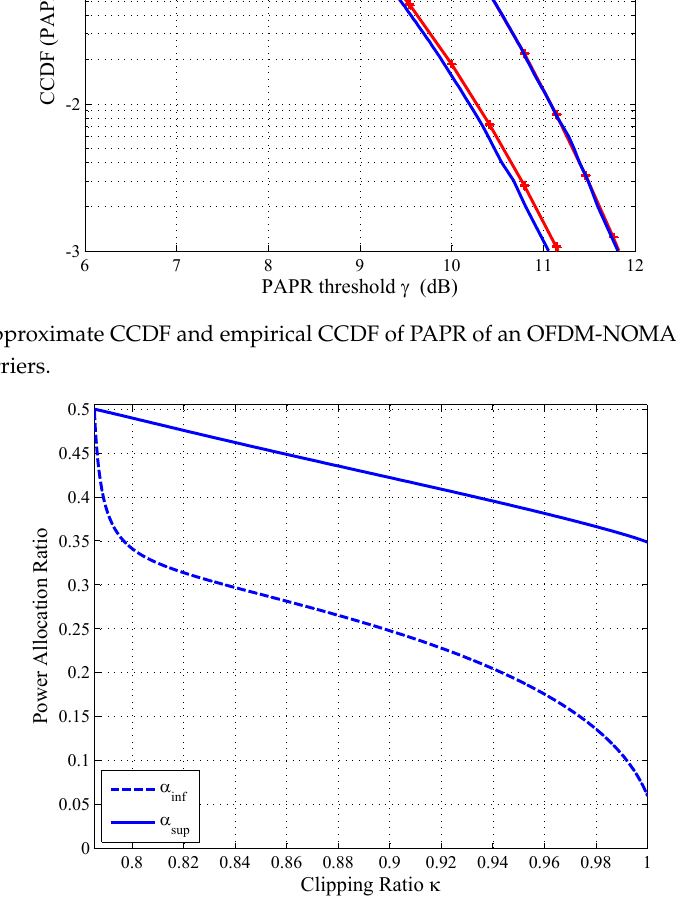
Figure 2. Lower and upper bounds of power allocation region for Fair OFDM-NOMA versus clipping